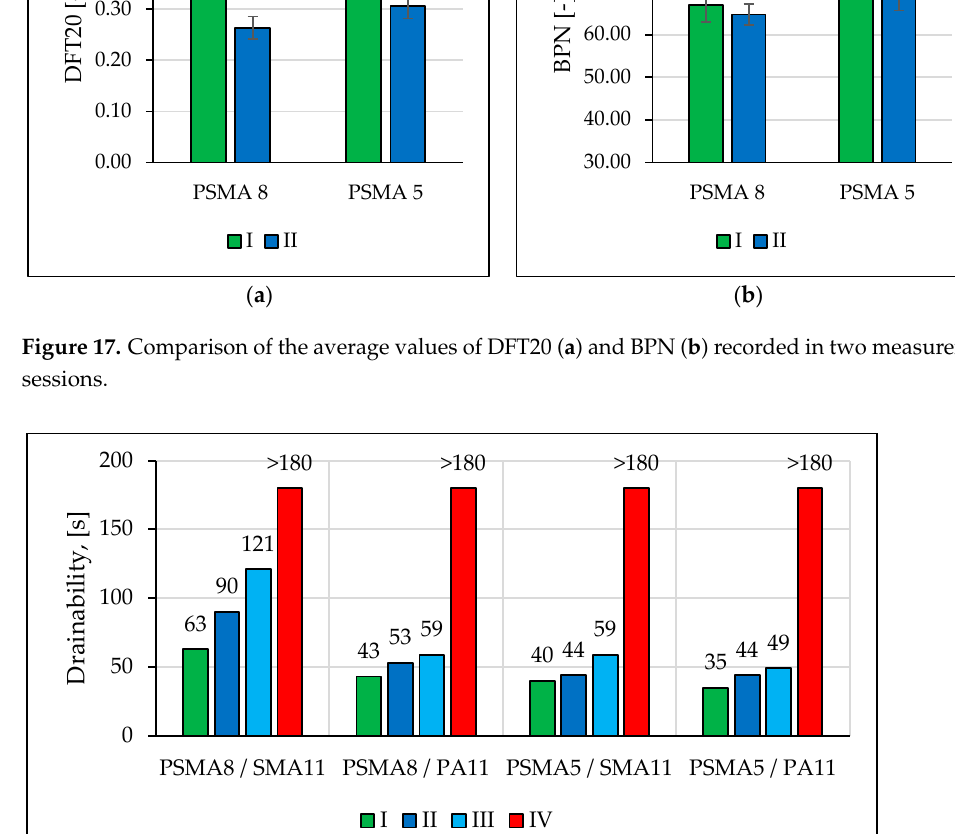
Figure 18. Evaluation of drainability of poroelastic pavements on test sections in four measurement sessions.